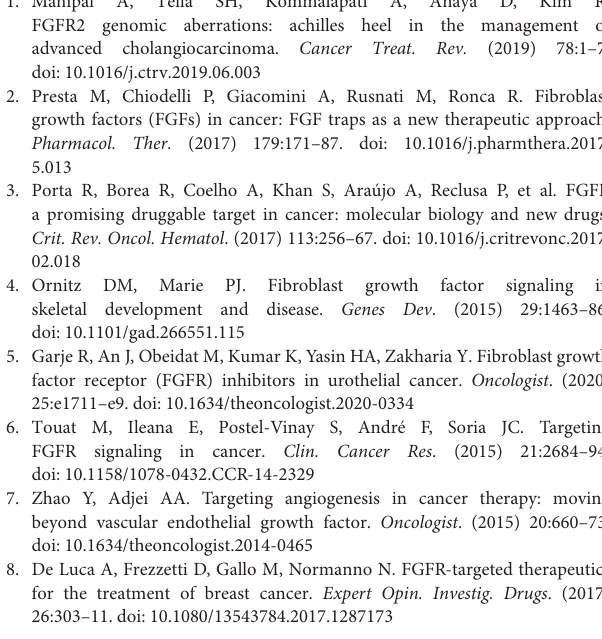
Supplementary Table 3 | Somatic mutation distribution in different functional domains of FGFR2 for cancers with FGFR2 mutations and all cancers